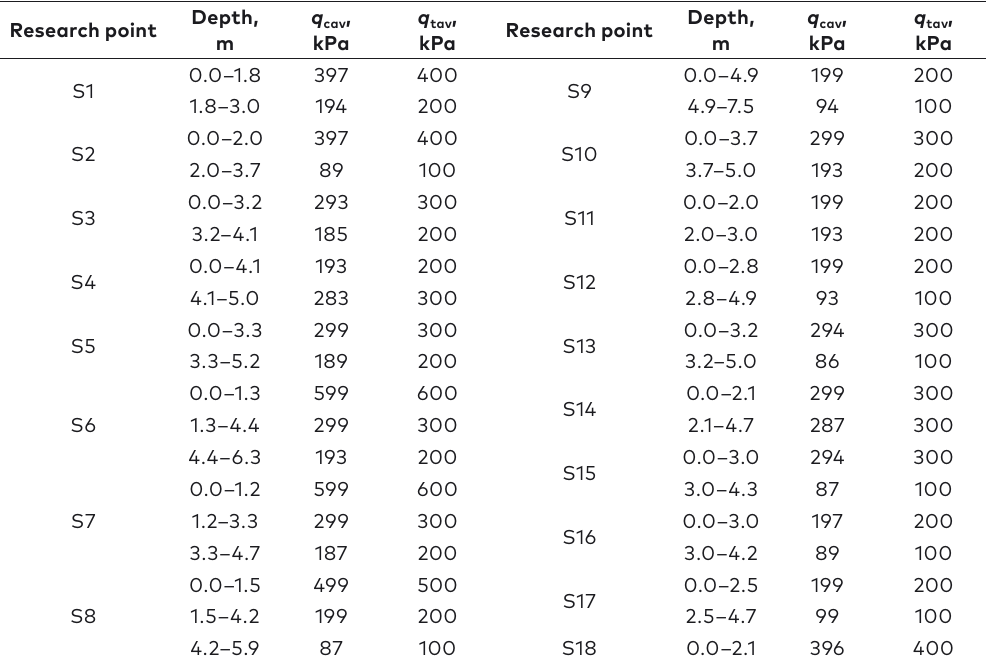
Table 4. Averaged values of cone resistances q cav and q